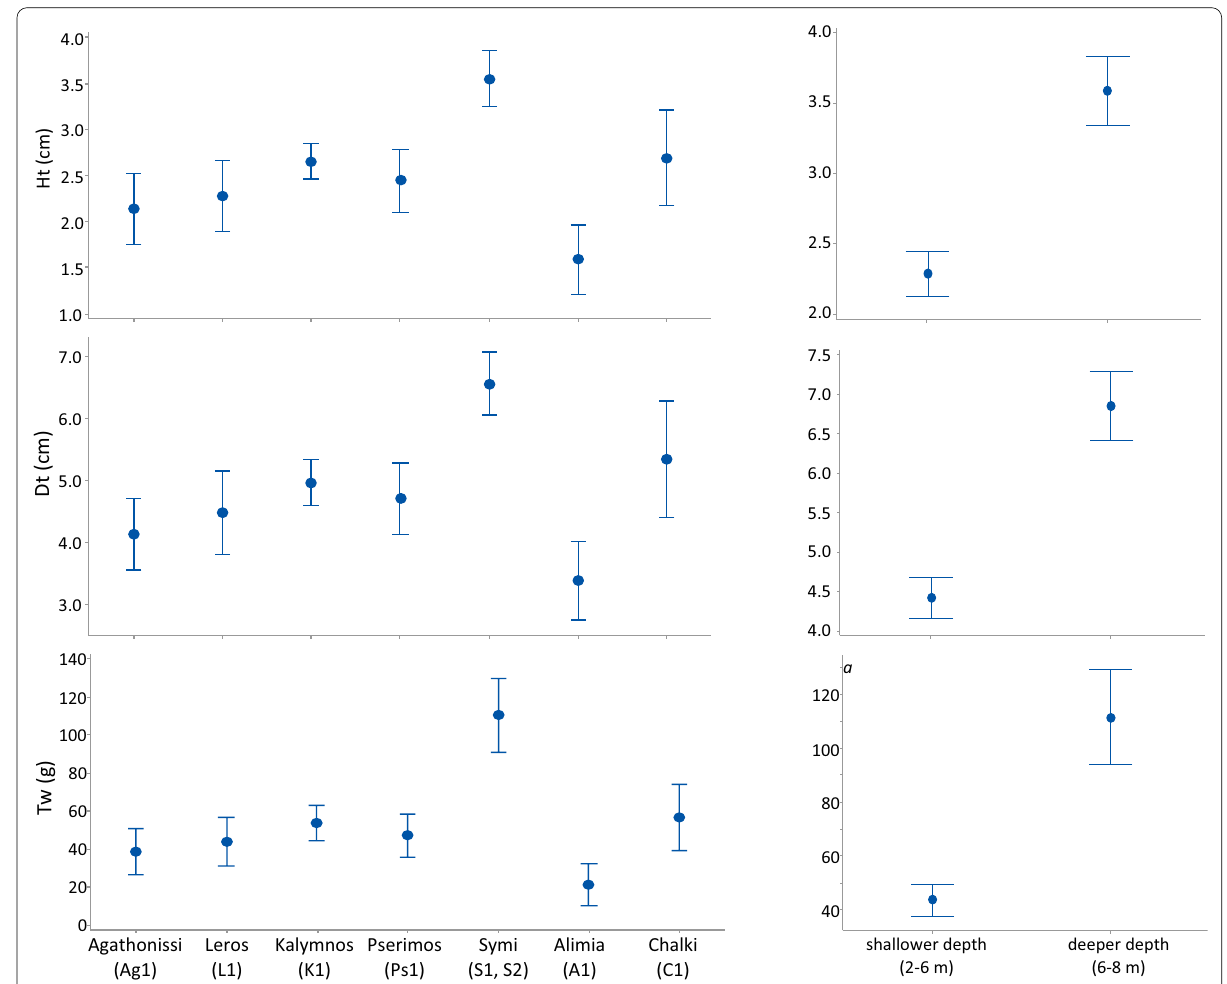
Fig. 3 Mean size (Ht test height, Dt test diameter) and biomass (tW = = (A, C or F relative abundance grade) islands (left) and in the two depth zones (right)